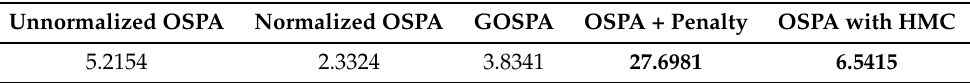
Figure 3. Association results in OSPA calculation step. ( a ) The association result with OSPA, where “X”, “Y” point sets stand for two finite sets. An incorrect association case and a cross-error case are circled. ( b ) The association result of OSPA-type metrics are extended with HMC labels. Table 2. The numerical results of unnormalized OSPA, normalized OSPA, GOSPA, OSPA plus miss-classification penalty and OSPA extended with HMC label